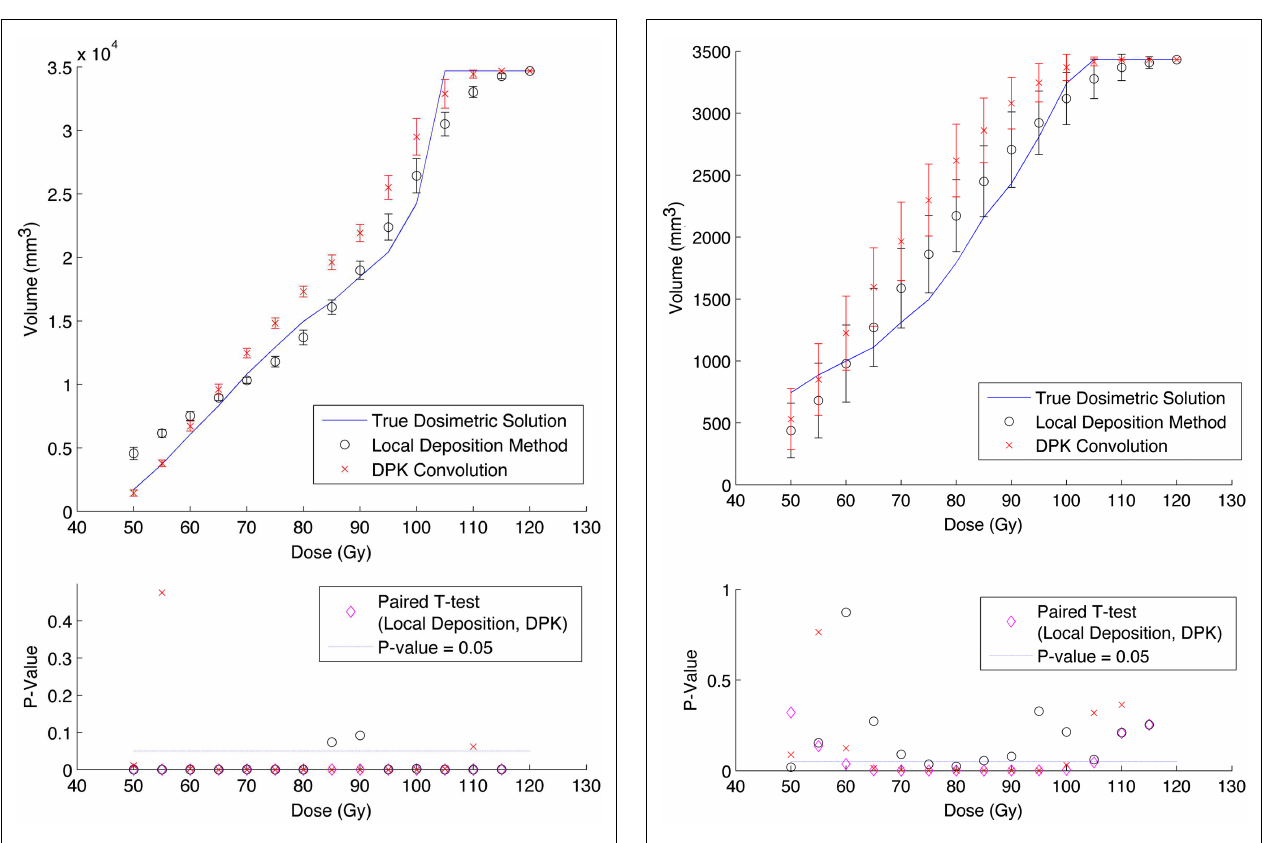
forwhichfiguresarenotpresented,theincreasedaccuracyafforded